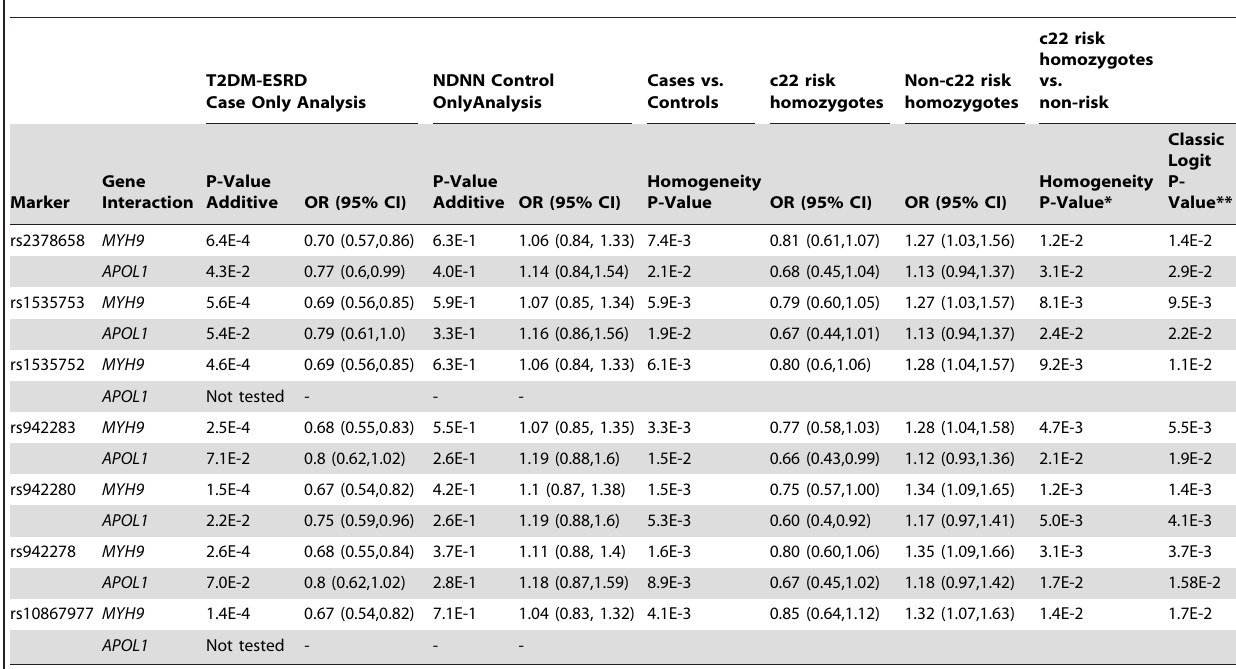
Table 2. Discovery sample chromosome 22- FRMD3 interaction